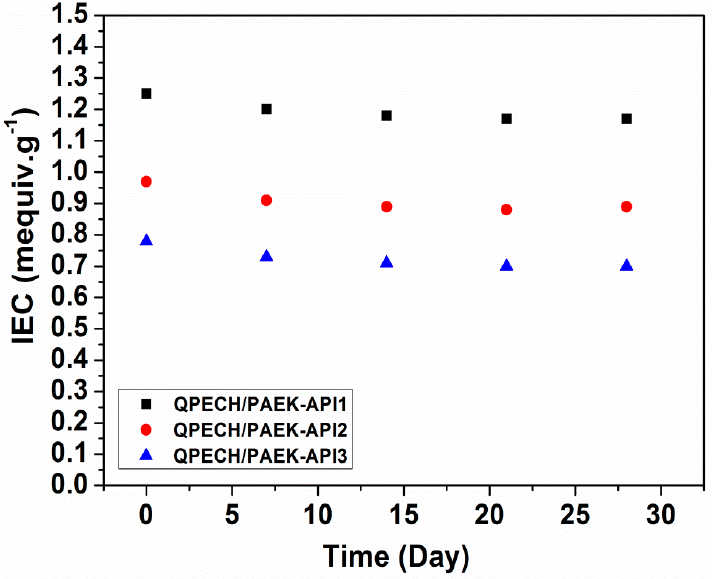
/ PAEK-API membranes as a function of time in 4 M NaOH at 60 ◦ Figure 8. IEC values of QPECH/PAEK-API membranes as a function of time in 4 M NaOH at 60 °C. Figure 8. IEC values of QPECH